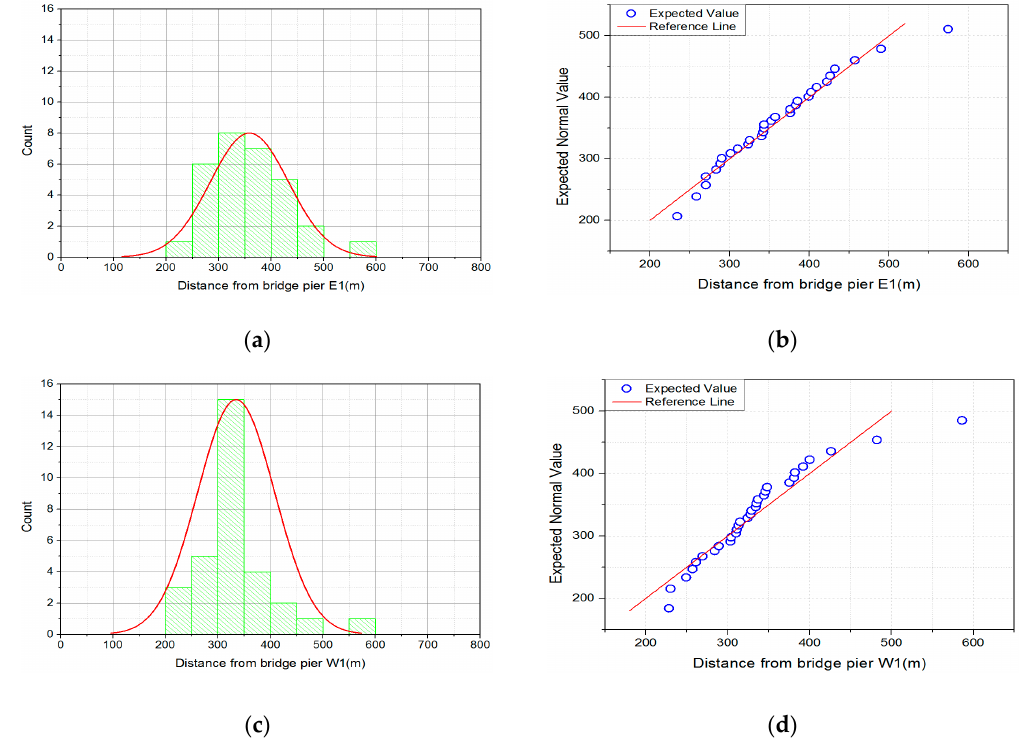
Figure 9. Histogram and Normal Q–Q plots for the Incheon bridge data for ( a , b ) 1-way arrival, and ( c , d ) 1-way departure.